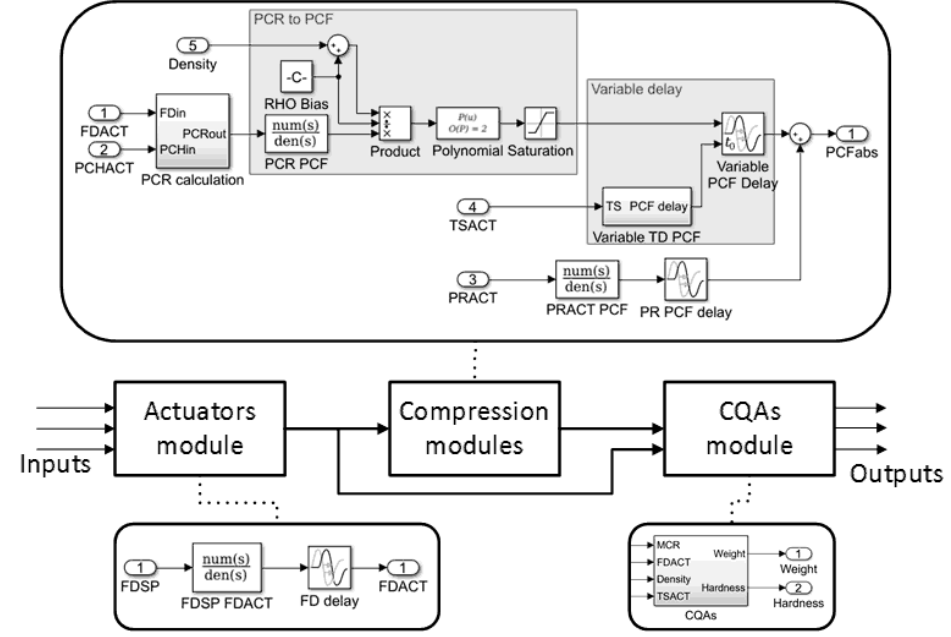
Figure 4. Model implementation overview. FDACT: Fill depth; PCR: Pre-compression ratio; PCF: Pre-compression force; RHO: Density; PRACT and PR: Production rate; TD: Transport delay; FDSP: Fill depth set point; CQA: Critical quality attribute.